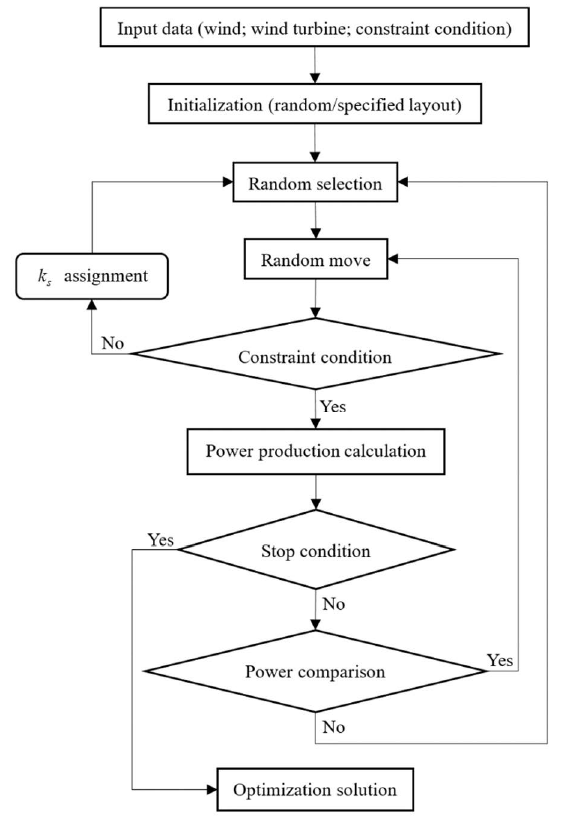
Figure 1. Flowchart of the optimization methodology.